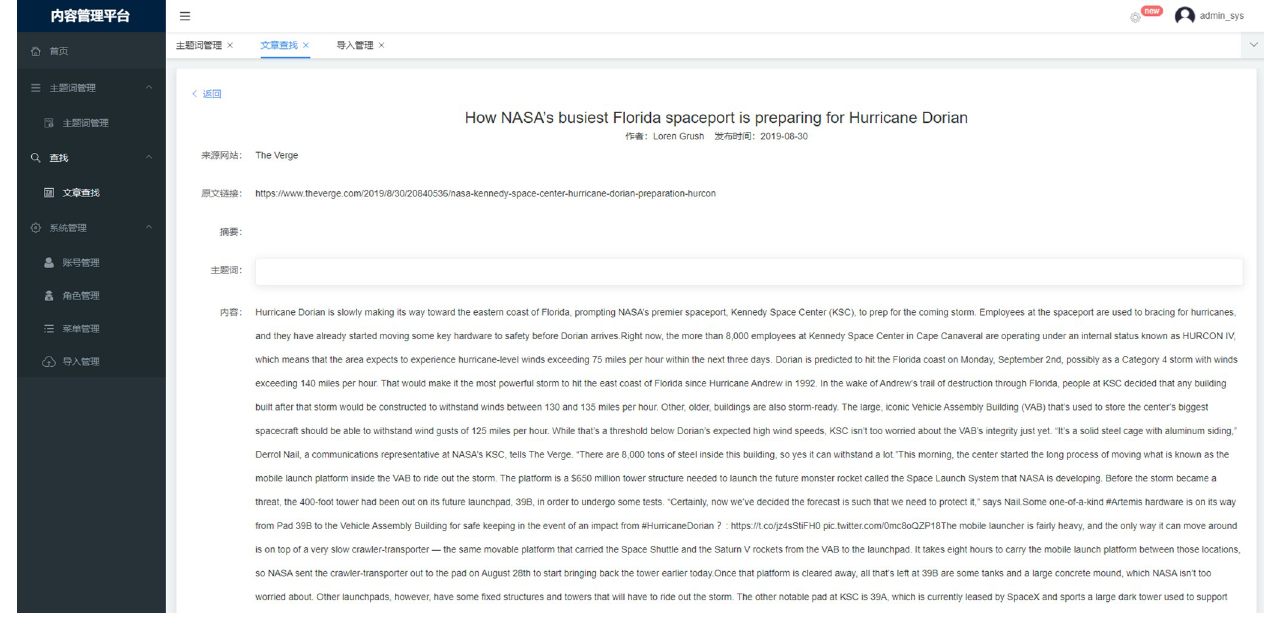
Fig 11. International cutting-edge technology identification article